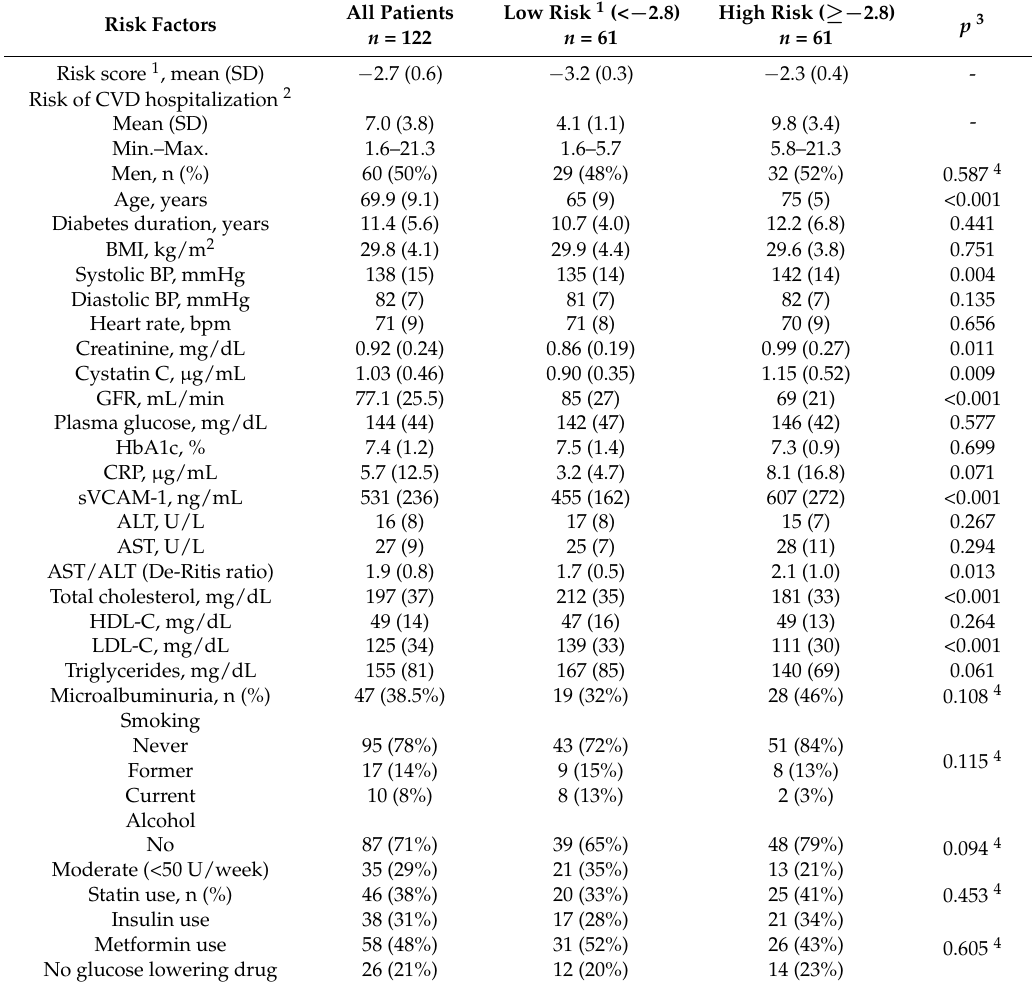
Table 1. Main characteristics of patients with type 2 diabetes according to the risk of cardiovascular